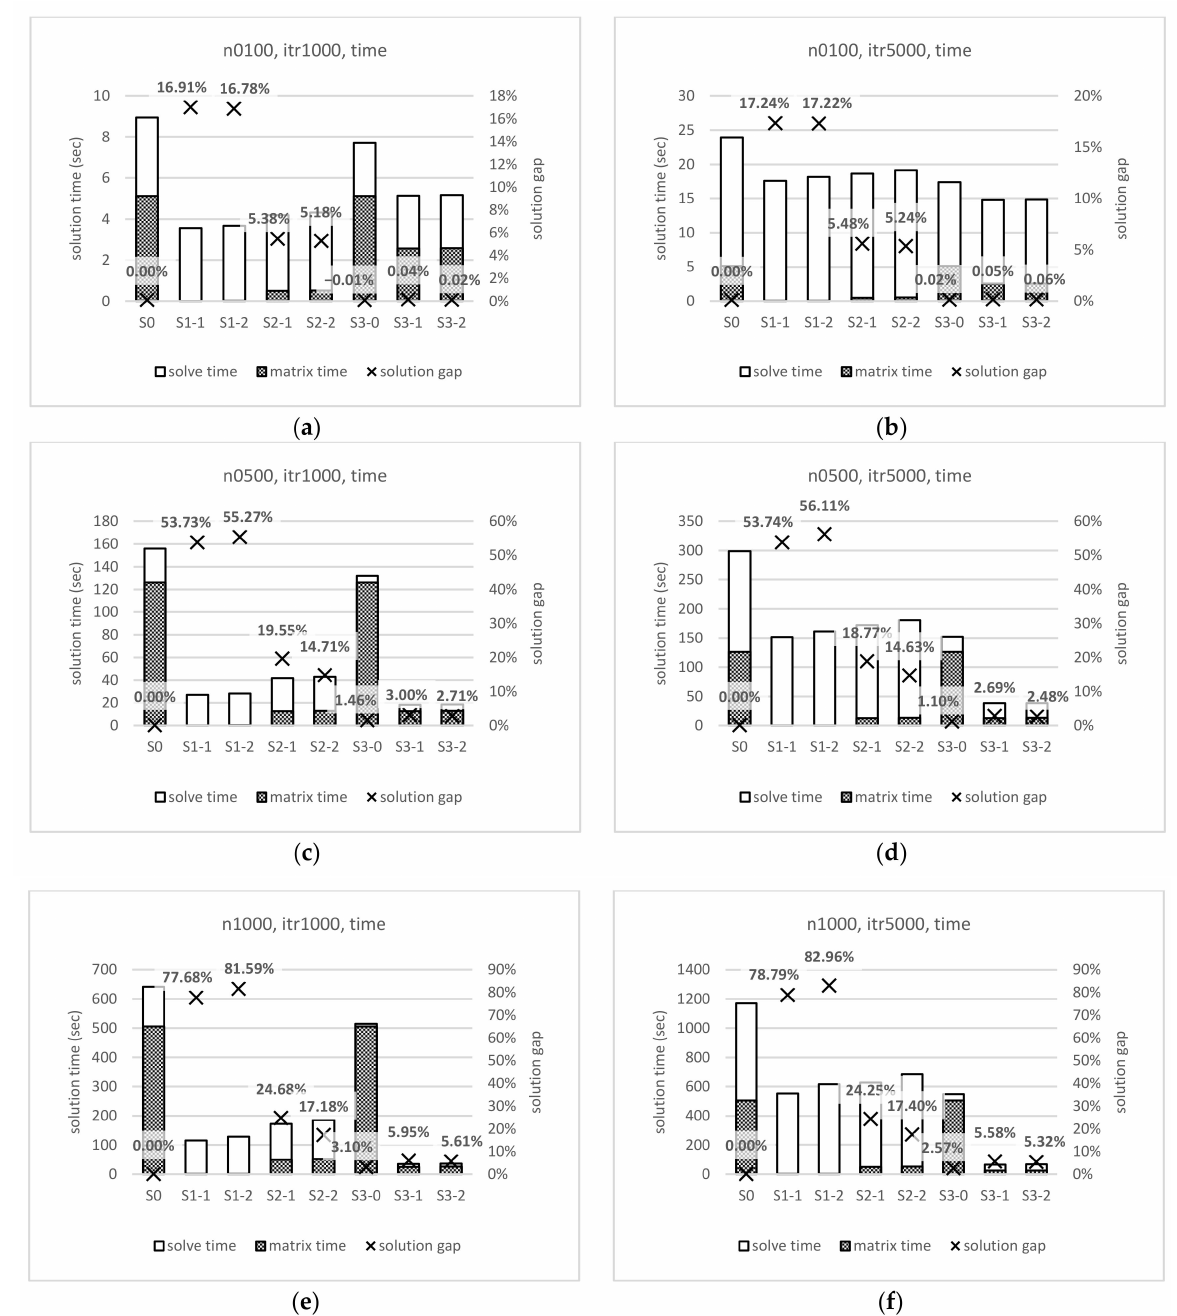
Figure 12. Solution time and gap for experimental scenarios with cost matrix type of time. ( a )